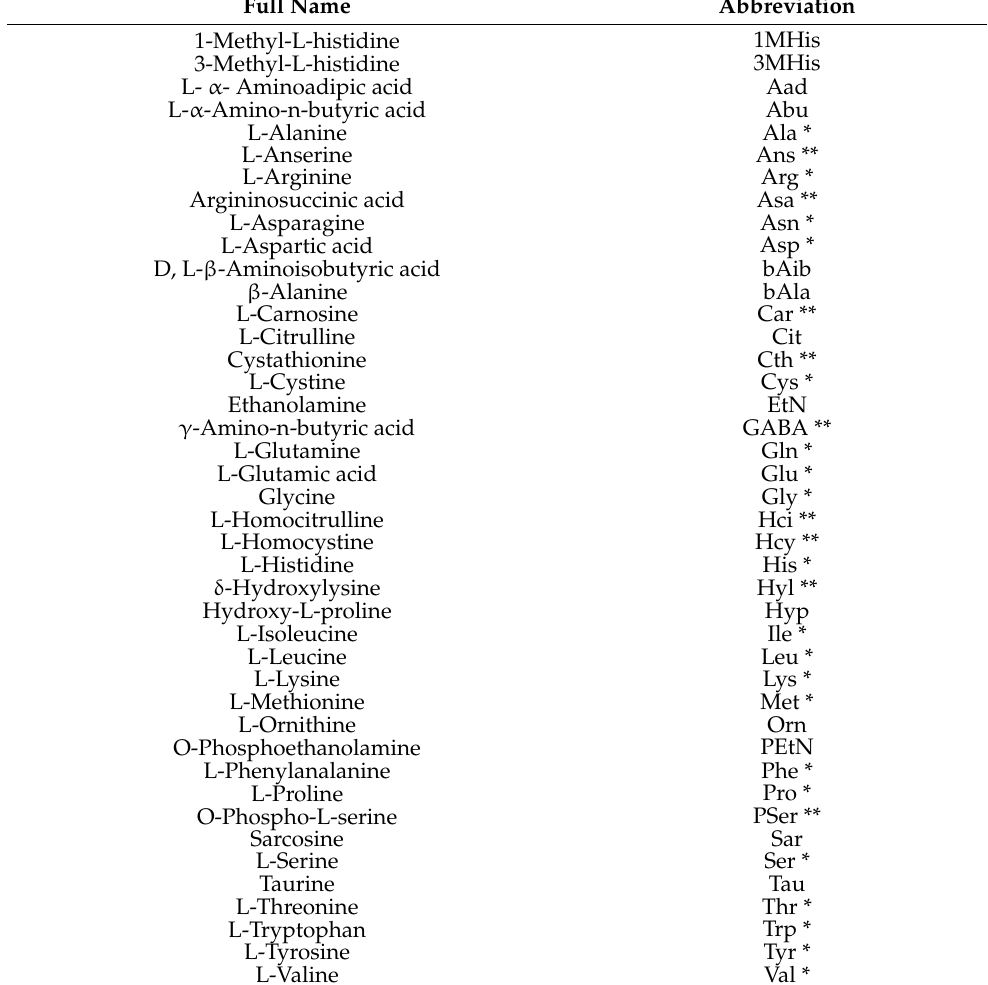
Table 1. List of analyzed amino acids and biogenic amines in